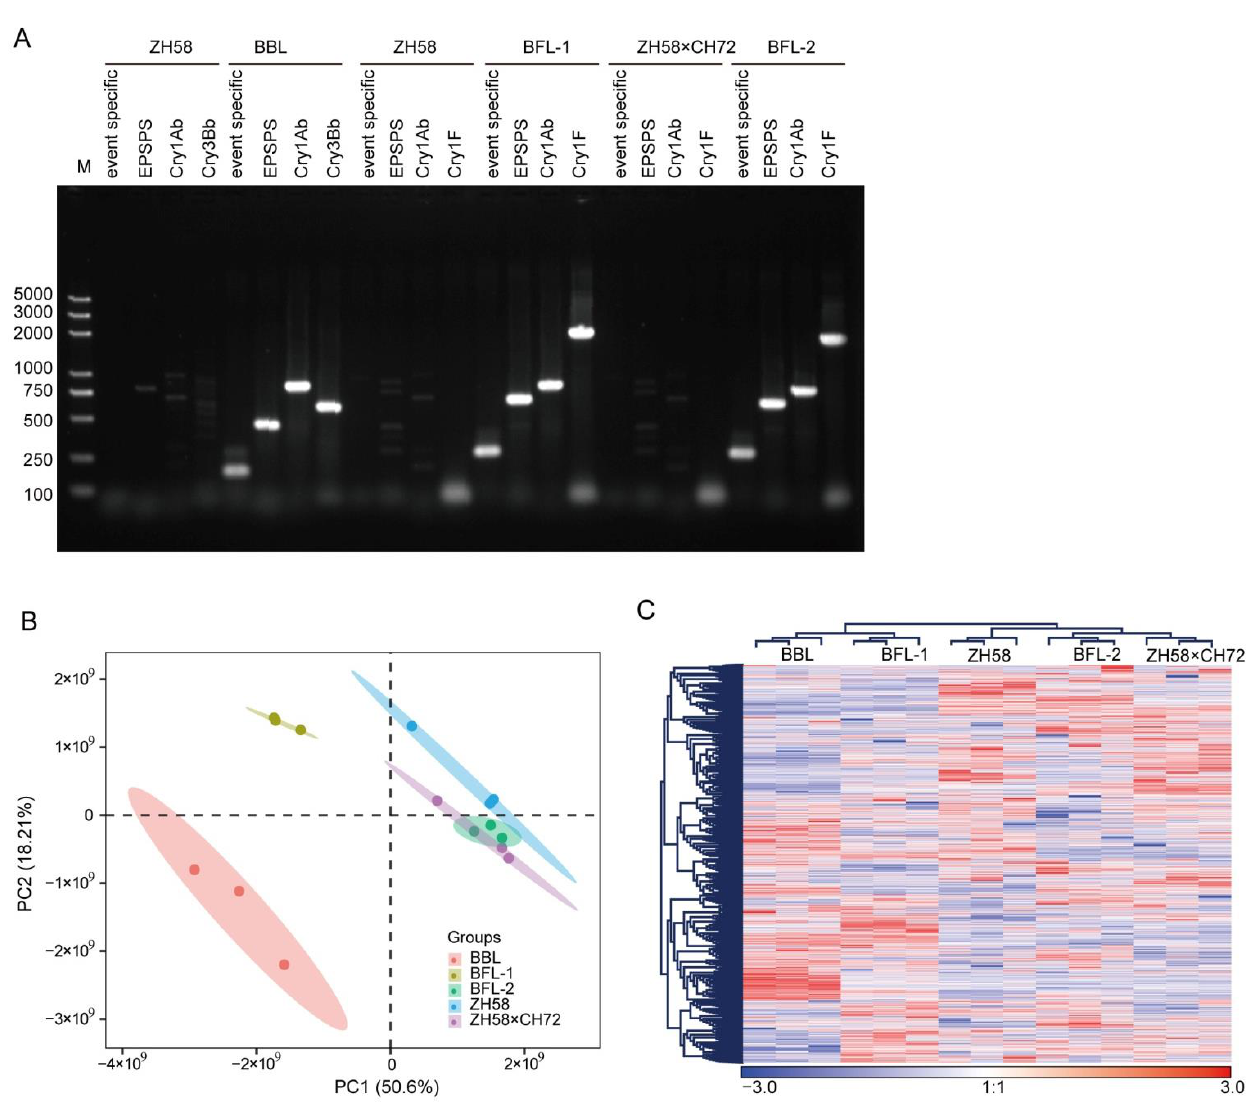
Figure 1. Proteomic profiling of seeds of the studied maize varieties. ( A ) Event- and gene-specific PCR-based detection of the studied GM maize varieties. M, Trans2k plus marker. ( B ) Principal component (PC) analyses of the protein levels in the seeds of five maize varieties. Score plot of the first two PCs with the explained variance. ( C ) Cluster map comparing the DEP regulation patterns. Red indicates relatively high expression, blue indicates relatively low expression, and white indicates the same expression levels in the two lines. All MS data were normalized and then applied in cluster analysis.